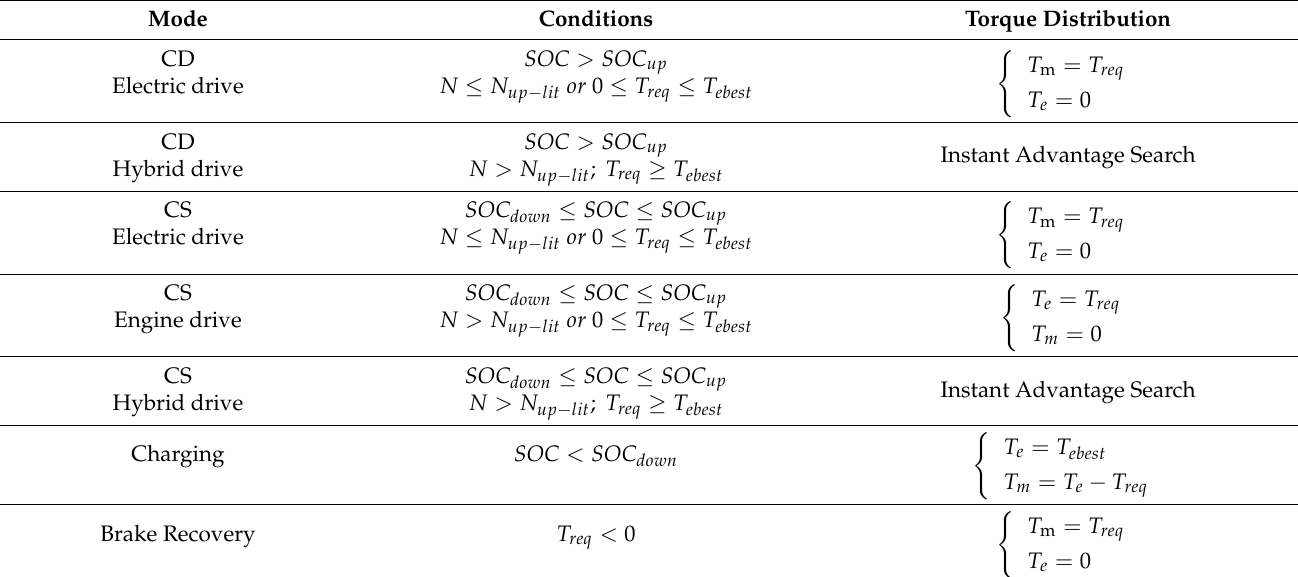
Table 3. Energy management control strategy.